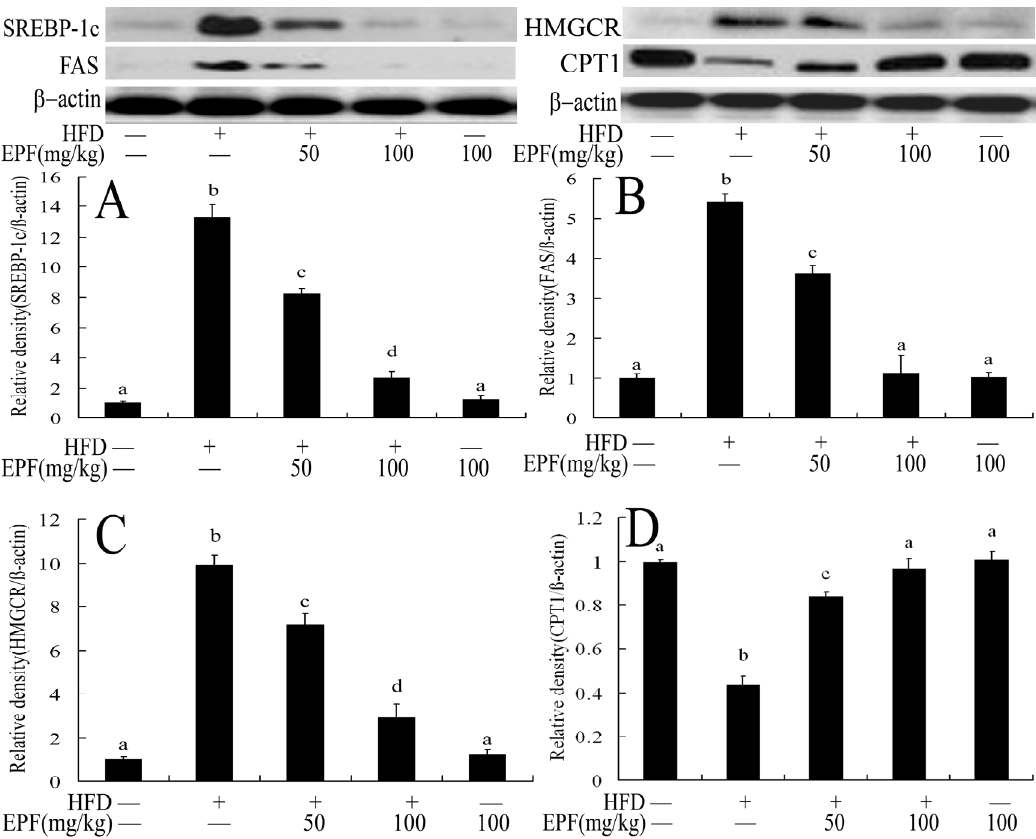
Figure 5. Western blot analysis of protein expression levels in association with the hepatic lipid metabolism in mice: ( A ) relative density analysis of HREBP-1c; ( B ) relative density analysis of FAS; ( C ) relative density analysis of HMGCR; and ( D ) relative density analysis of CPT1. β -Actin was probed as an internal control in relative density analysis. The vehicle control is set as 1.0. Significant differences among the groups were assessed by one-way ANOVA with Tukey’s post hoc test.